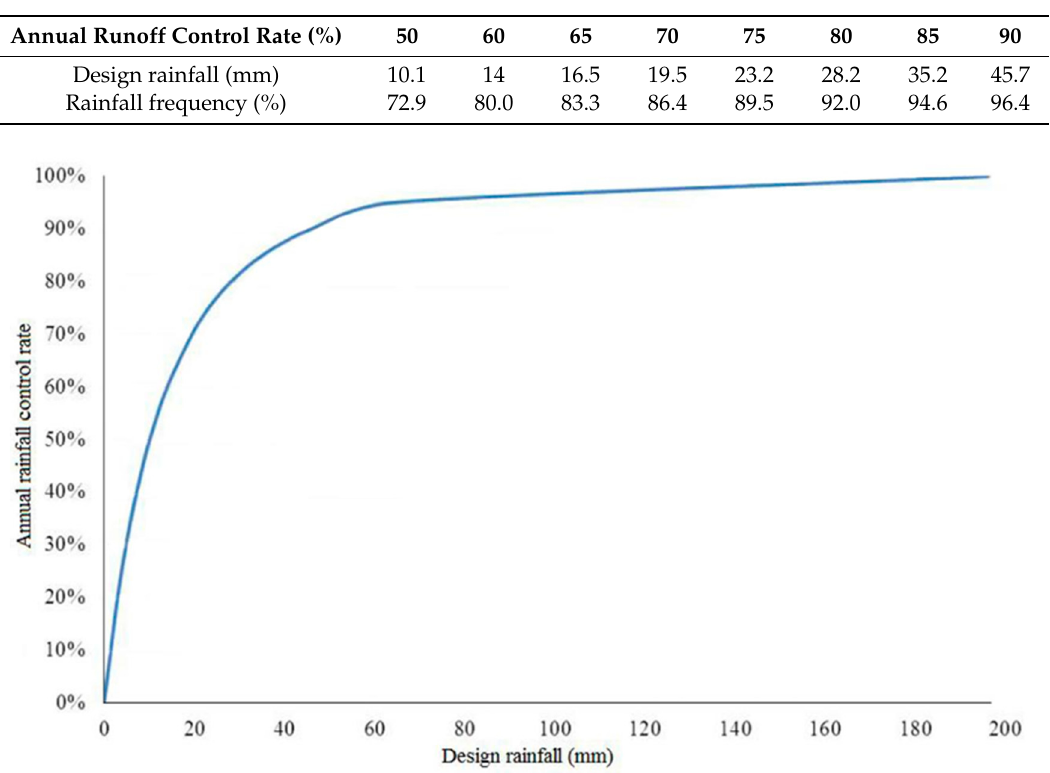
Table 1. Comparison of annual runoff control rate, the design rainfall and rainfall frequency in Changzhou city.